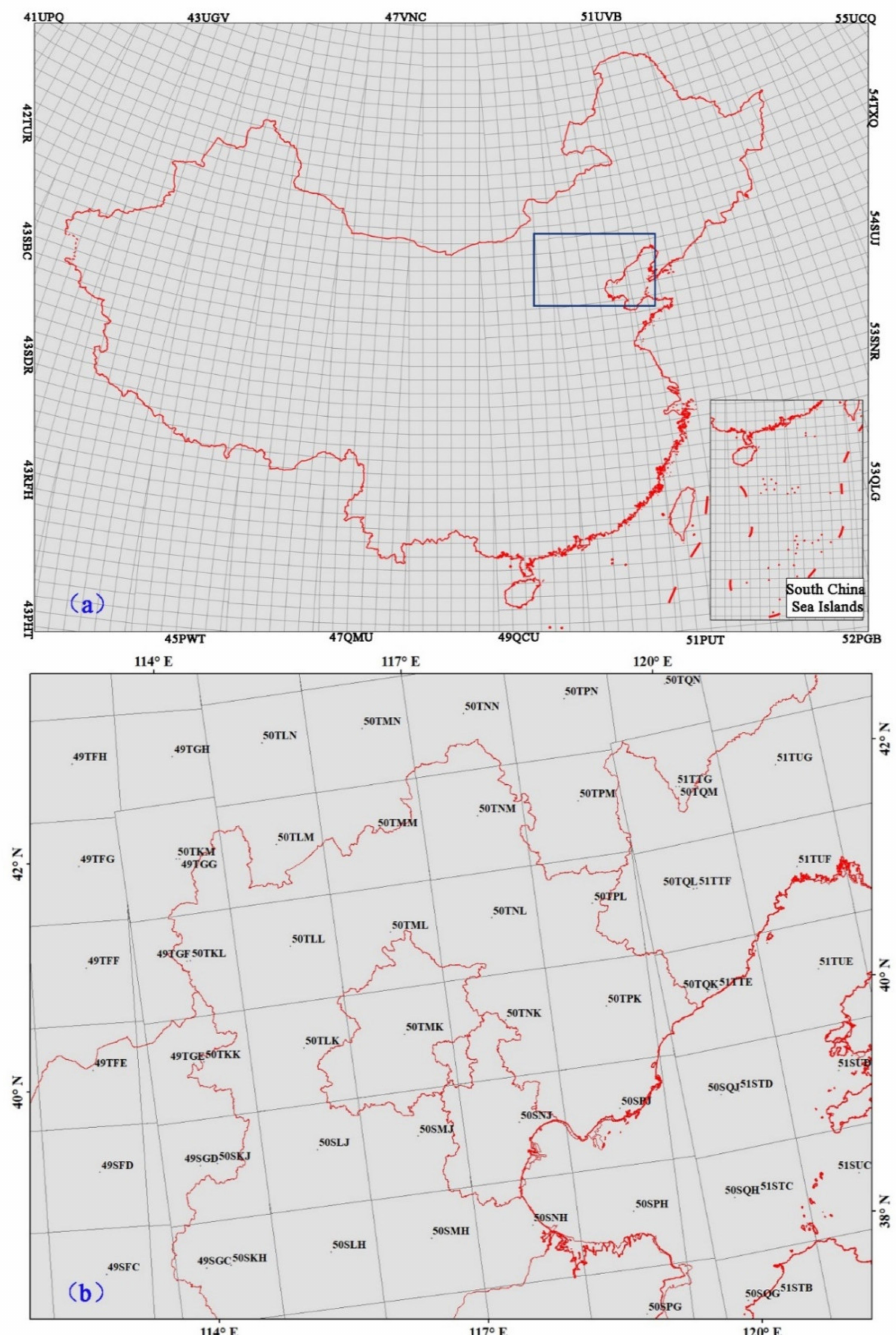
Figure 3. Horizontal and vertical ARD tile coordinate maps of GF1-WFV in China and its surrounding areas, each tile covers an area of 100 × 100 km and is composed of 6863 × 6863 16 m pixels. ( a ) Tiles in China. ( b ) Details of tiles cover the blue box area in ( a